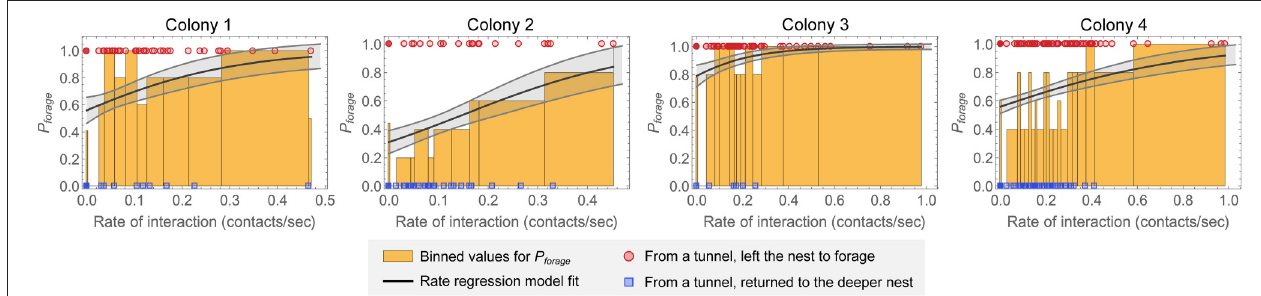
FIGURE 4 | Rate regression fit for fraction that leave the nest to forage as a function of interaction rate. Results are shown for each observation of a colony. Red points show interaction rates of ants that left the nest to forage, and blue points show interaction rates of ants that returned to the deeper nest. The bins for P forage are determined by sorting the nonzero interaction rates, forming bins with a fixed number of points per bin (5 points per bin was used), and calculating the fraction of points in each bin that represent ants that left the nest to forage. A separate bin was used for ants with zero interactions; this bin is shown as the separate line at zero. The solid line is a fit of the rate regression model (Equation 1). The fit standard deviation for this model was estimated using bootstrapping; the shaded area around the best fit indicates the standard deviation of the fits for P forage for each value of the rate of interaction.